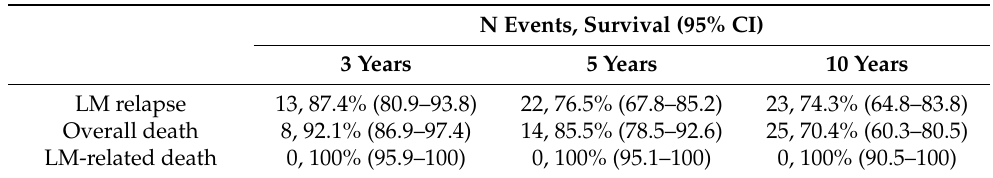
Table 3. Kaplan–Meier estimates of disease-free, overall, and lentigo maligna-related survival in the study population.